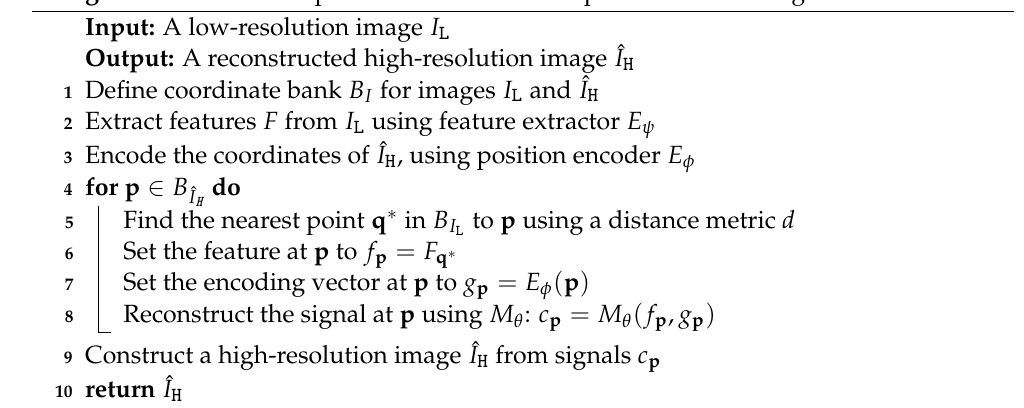
Algorithm 2: Inference process of continuous super-resolution using